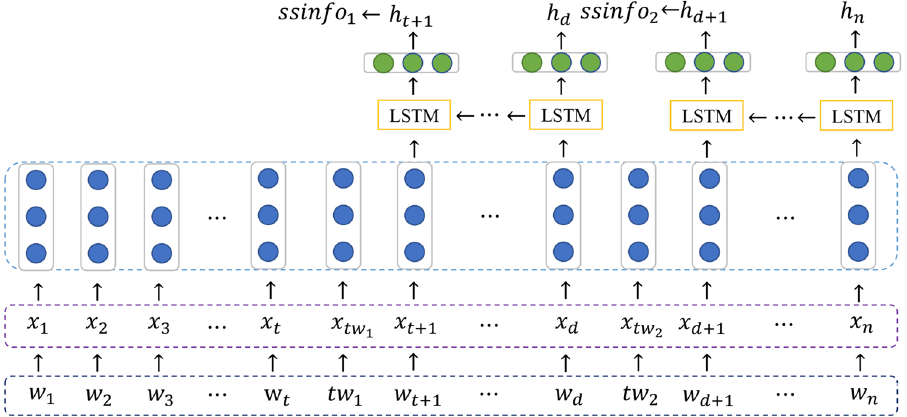
Fig. 2 Sentiment supplement